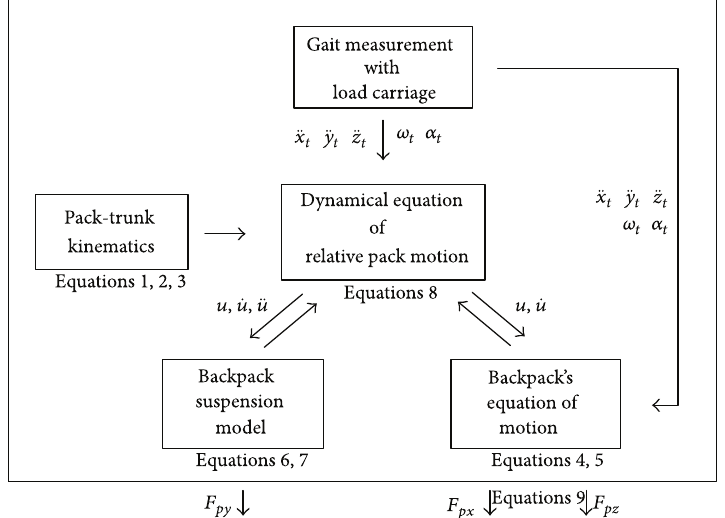
Figure 4: The schematic diagram for the pack-bearer interaction force calculation based on pack-trunk kinematics, backpack’s equation of motion, and backpack suspension model.